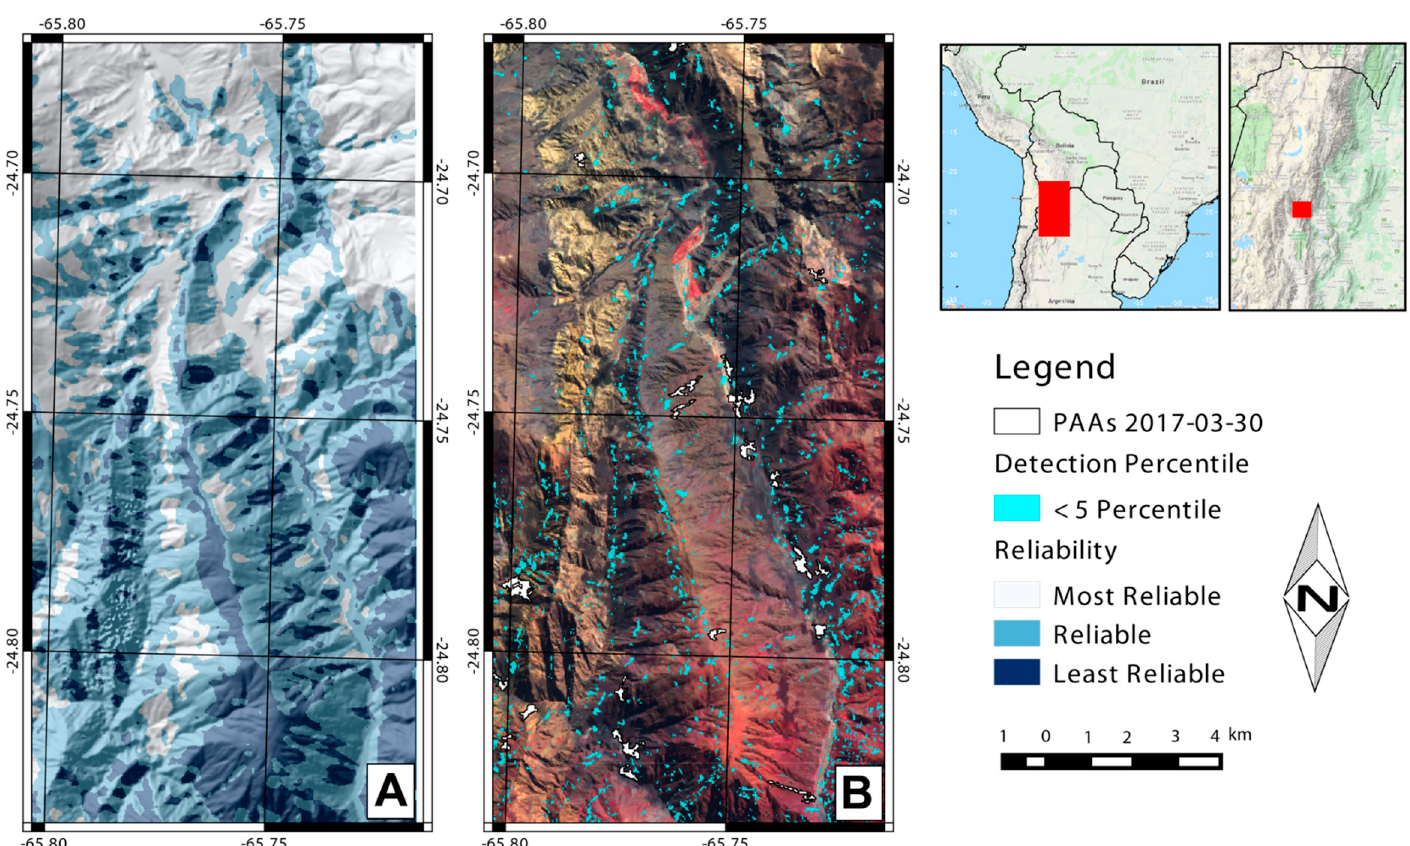
Figure 5. Example of the potentially affected area algorithm in use for event detection in the Quebrada del Toro, Argentina. ( A ) Reliability map for region. This highlights that in very steep areas, such as the highlighted section of the valley, coherence values are noisier and more complicated to interpret; ( B ) False-colour Sentinel-2 composite the region of interest with the results of the PAA algorithm for the period between 18 March and 30 March 2017, following a period of intensified rainfall (cf. Figure 6). All regions below the 5th percentile of coherence values 2014–2016 are shown in blue. PAAs (<1st percentile) are shown in white. PAAs detected in steep sections of the valley such as this may pose a threat to critical transport infrastructure between the Puna de Atacama plateau and the Andean foreland. Inset map data: Google Maps.